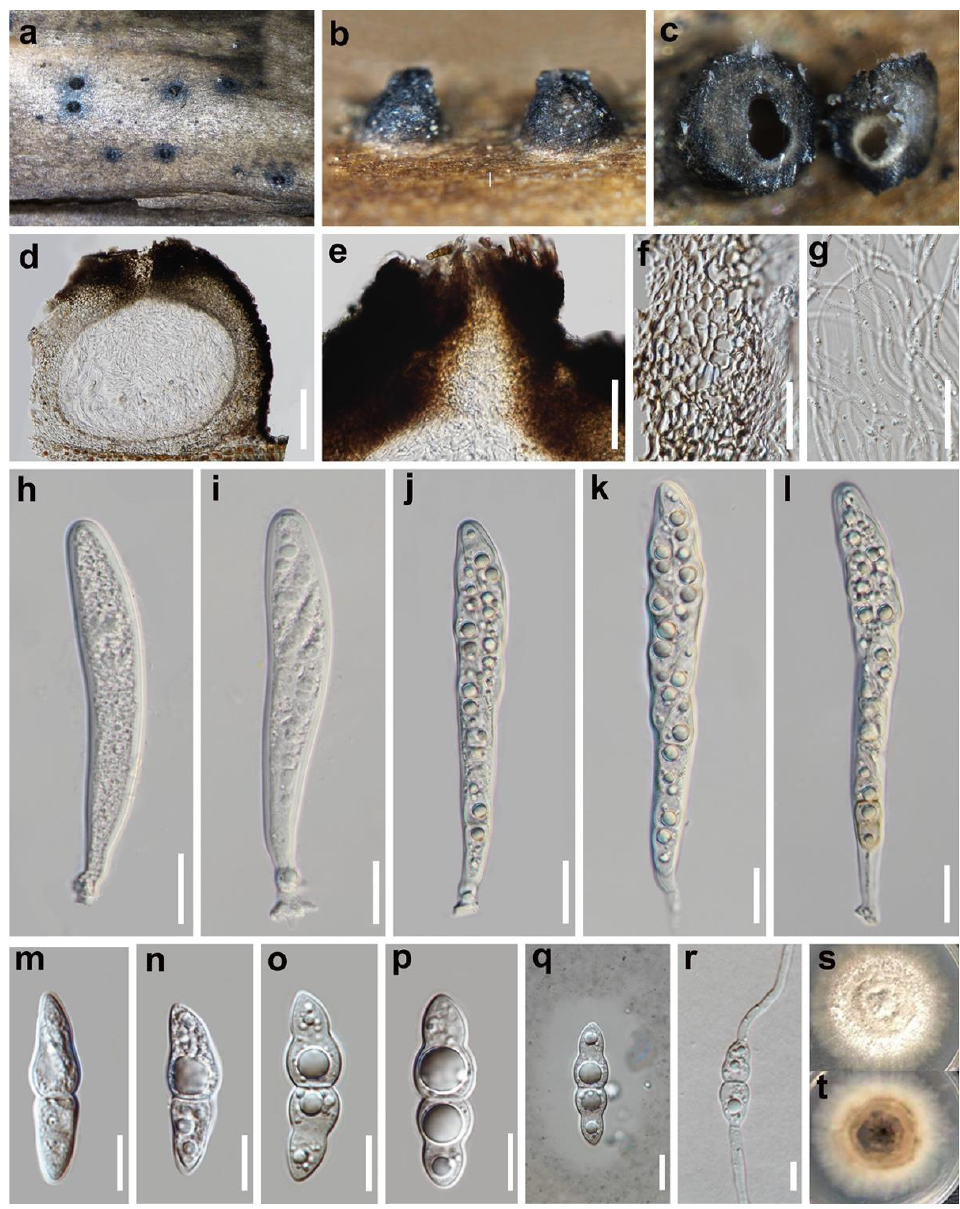
Figure 2. Crassoascoma potentillae (HKAS 115966, holotype) ( a – c ) Ascomata on host surface. ( d ) Vertical section of ascomata. ( e ) Ostiole. ( f ) Peridium. ( g ) Hamathecium. ( h – l ) Asci, ( m – p ) Ascospores. ( q ) Ascospore stained with India ink showing the mucilaginous sheath. ( r ) Germinating ascospore. ( s , t ) Colony on PDA (4 weeks). Scale bars: d = 100 μm, e = 50μm, ( f – l ) , r = 20 μm, ( m – q ) = 10 μm. Culture characteristics: Ascospores germinated on PDA within 24 h. Colonies on PDA reaching 24 mm diam. incubated at 25 ◦ C after 4 weeks, circular, medium dense, cottony, flat to raised, entire margins, greyish-white, thinner and velvety at the margin, pale brown to brown from the